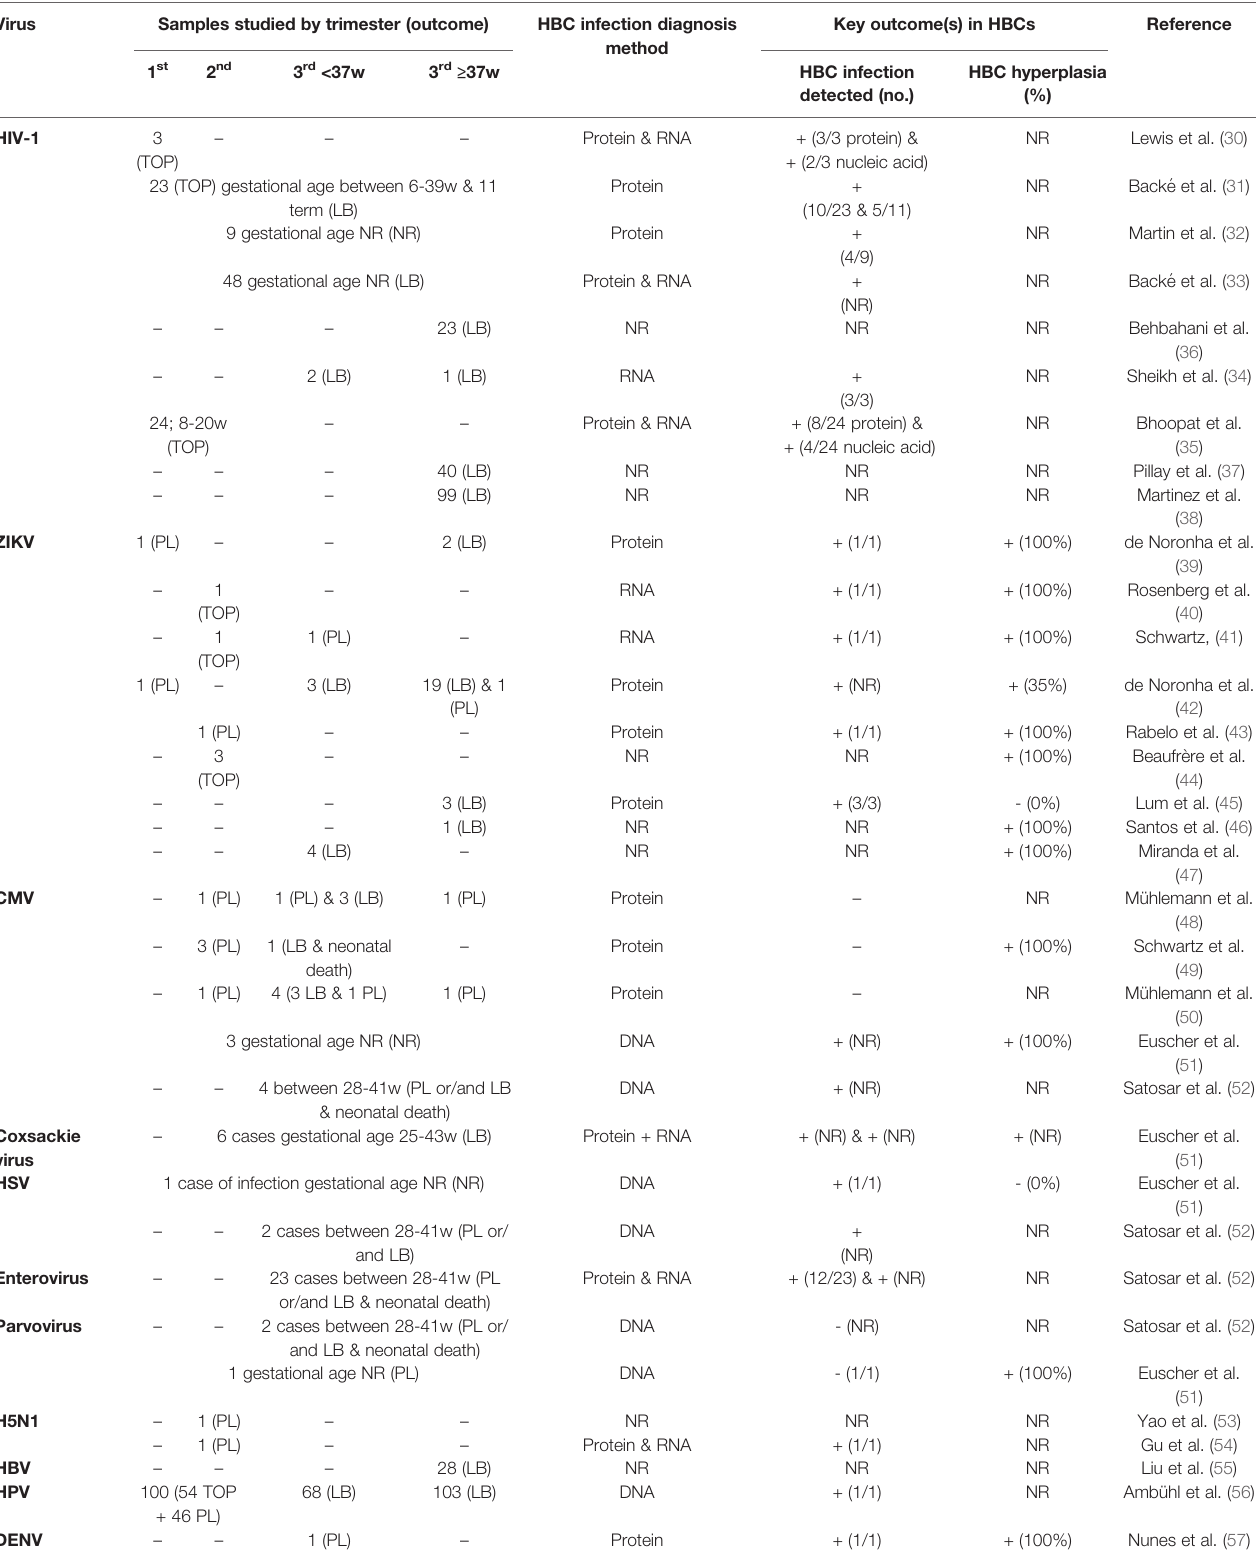
TABLE 1 | Hofbauer cells in observational studies of viral